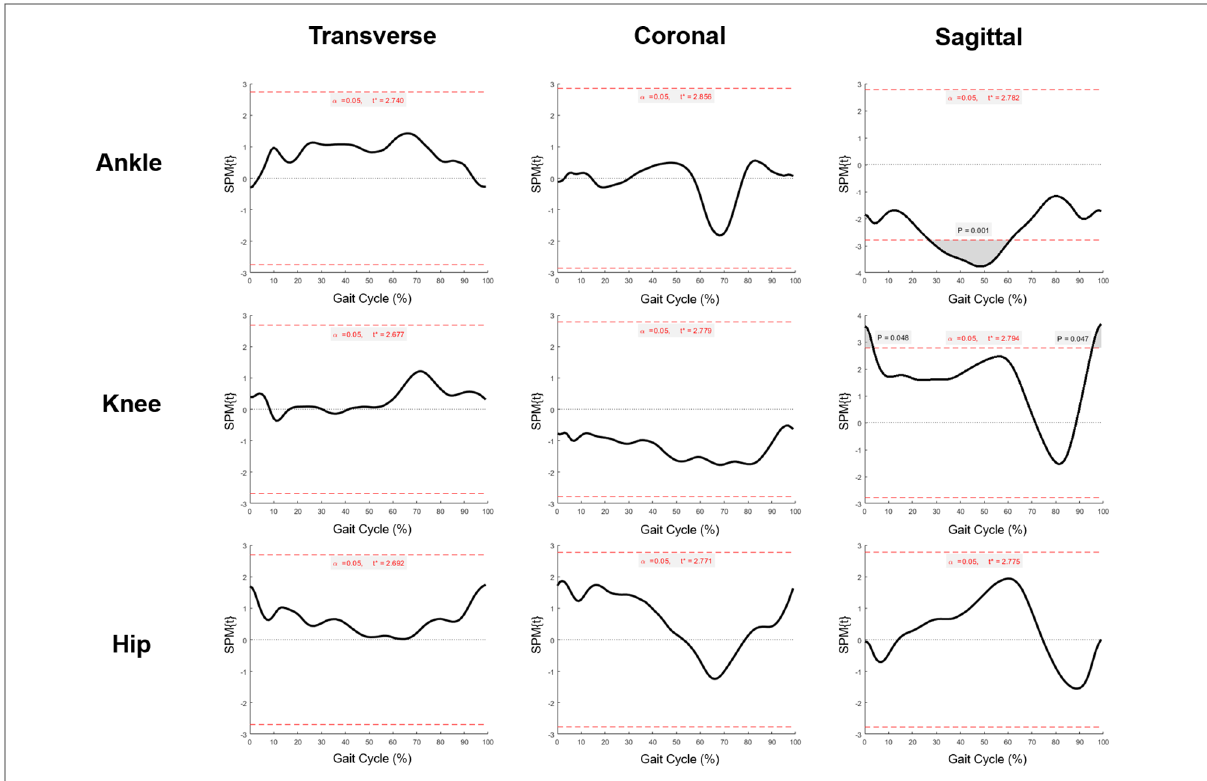
FIGURE 5 Statistical parametric mapping t tests of pre-operational and post-operational kinematic curves (ankle, knee and hip) in affected sides at transverse, coronal and sagittal plane. Grey region above/below the red dash line: statistical signi fi cance